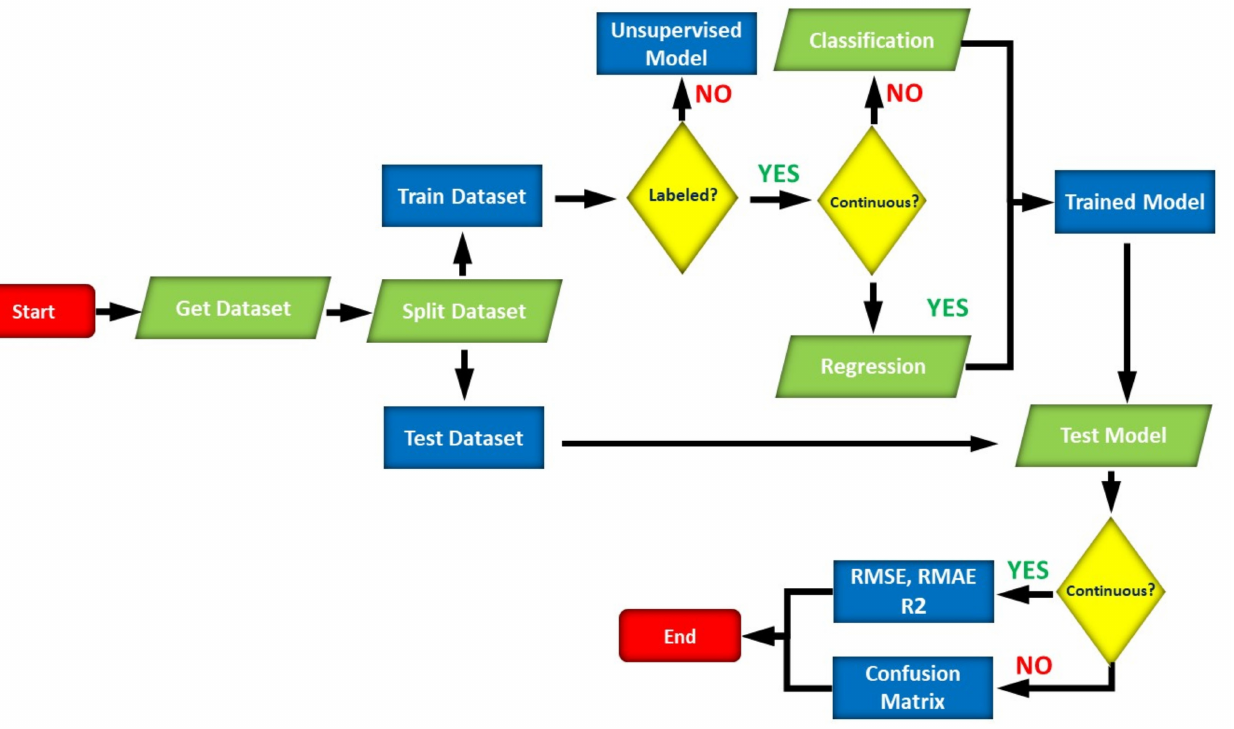
Figure 1. A typical flowchart of a machine-learning